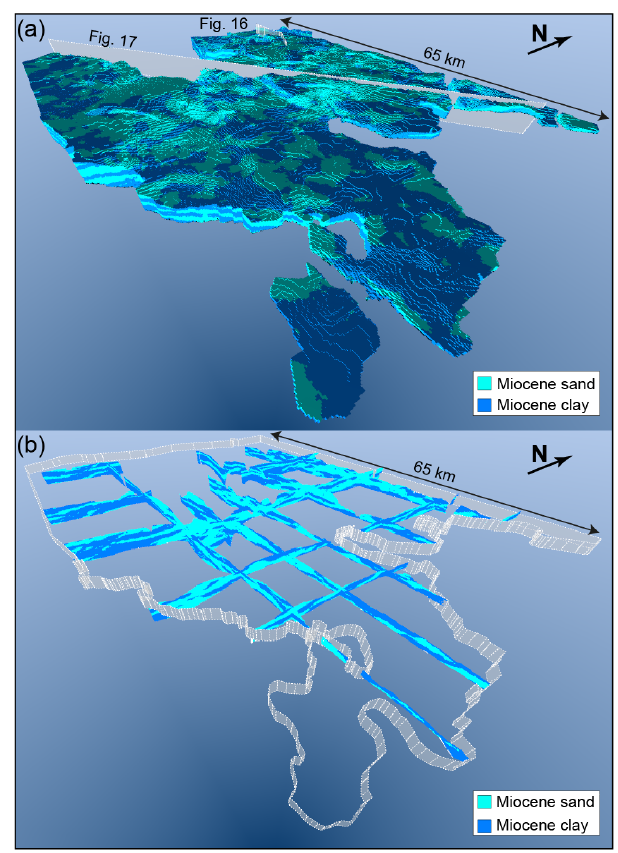
Figure 18. Three-dimensional view of the final realization (test d, Table 1). The associated 3-D probability grid is shown in Fig. 9. (a) All voxels are plotted and the location of the profile in Figs. 13 and 14 are shown. (b) The associated fence view. Vertical exagger- ation = 10 × .